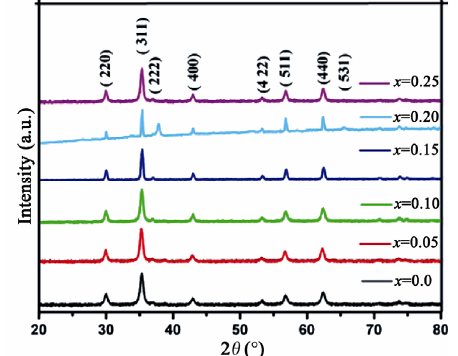
Fig. 1 XRD patterns of the Mg 0.25– x Co x Cu 0.25 Zn 0.5 Fe 2 O 4 (0 ≤ x ≤ 0.25) ferrites. sa mple magnetometer (Lake Shore 7410